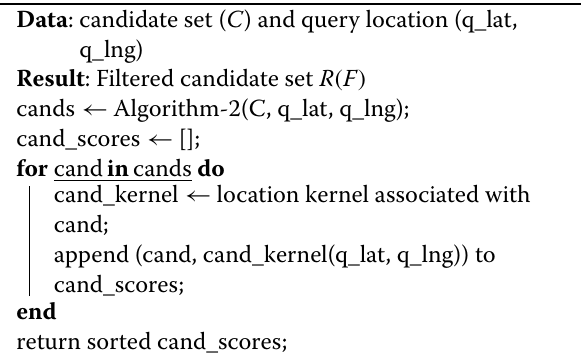
Algorithm 3: Location-based